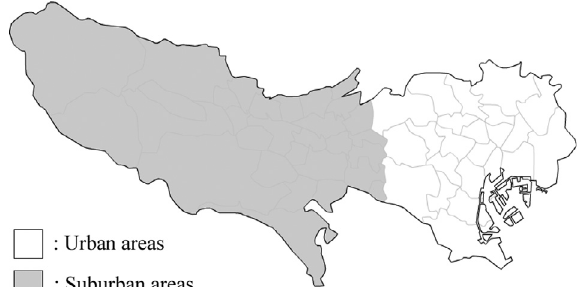
Figure 1. Urban and suburban areas: regions of origin of the shelter dogs tested for Dirofilaria immtis